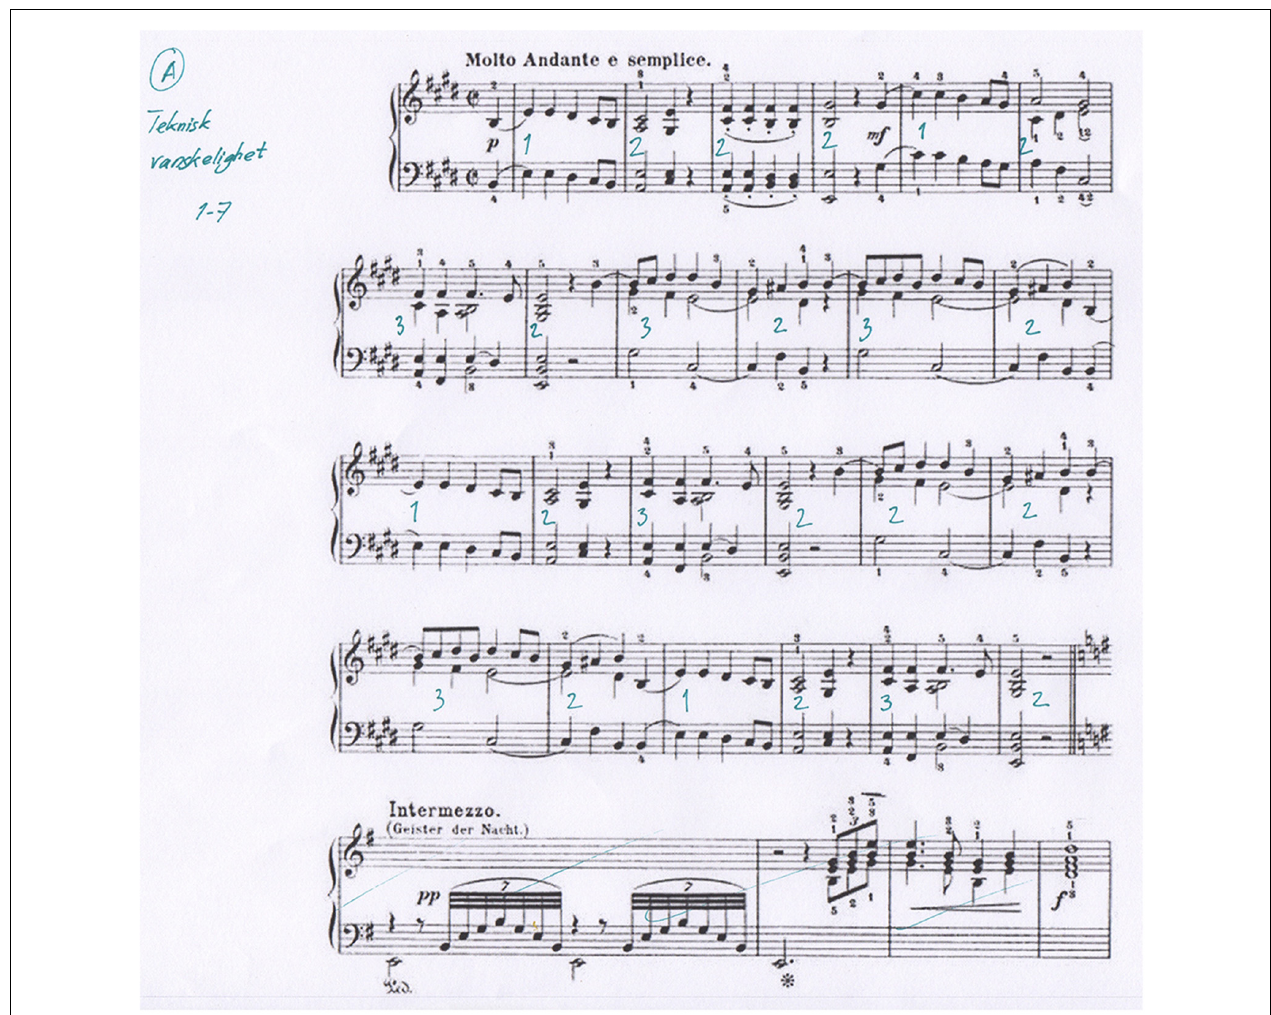
FIGURE 1 | The score of Grieg’s Wächterlied for piano, with annotations by the professional pianist of its technical difficulty (measure by measure on a 7-step Likert